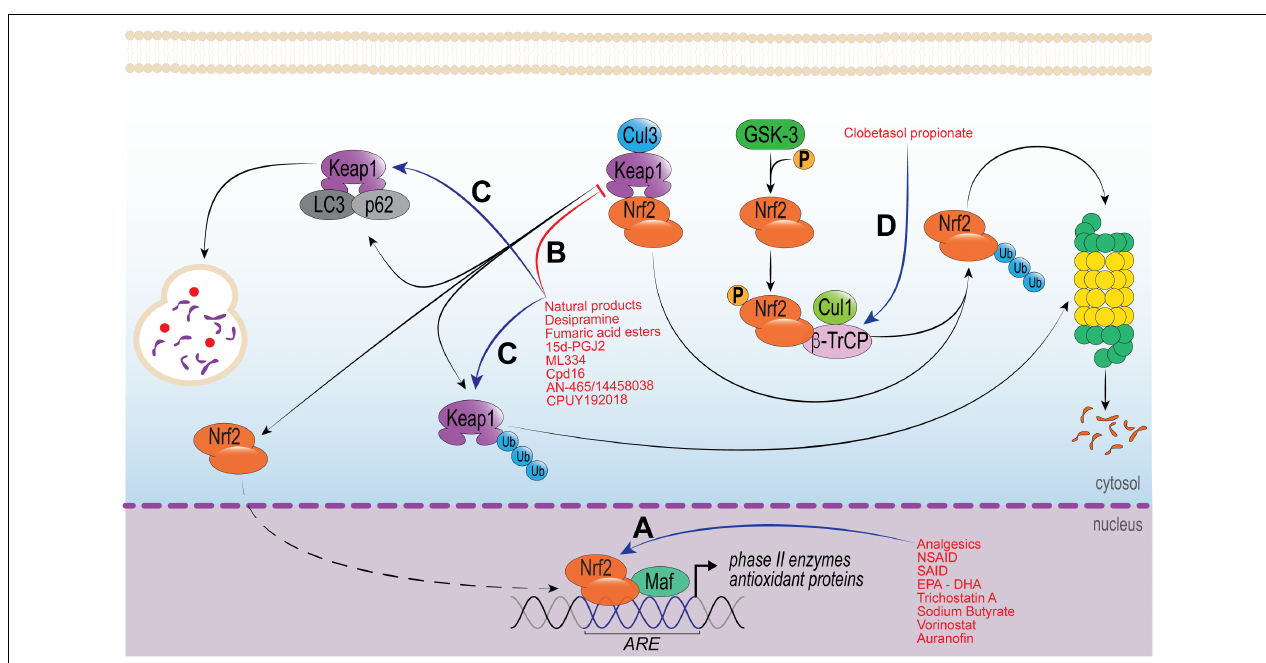
FIGURE 2 | Molecular mechanisms of drugs that modulate Nrf2 activity. (A) Group of drugs that increase Nrf2 biding to DNA and/or, Nrf2-Maf affinity to ARE region and/or modulate histone acetyltransferase (HDAC). (B,C) Drugs modulating the disruption of Keap1/Nrf2 complex; either (B) by protein–protein interaction though Michael addition reaction and/or, (C) increasing Keap1 degradation through proteasome or autophagic pathways. (D) Drug targeting the degradation of Nrf2 via proteasome by increasing the GSK-3/ β -TrCP signaling and reducing Nrf2